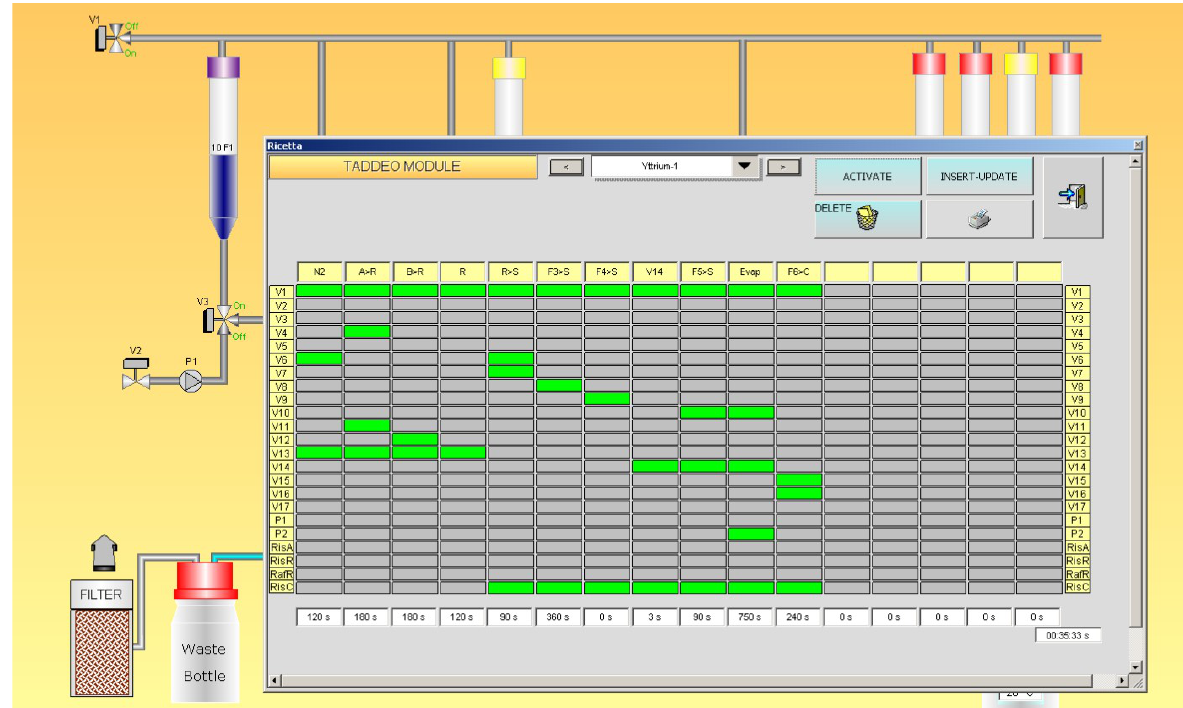
Figure 4. Remote-controlled process for the preparation of 90